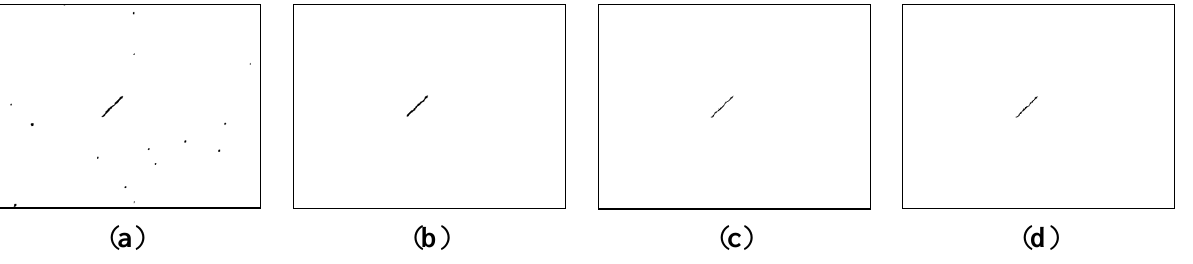
Figure 19. Detection of a MEO satellite, multiple methods. From left to right: ( a ) Motion detection using background subtraction; ( b ) Motion detection using background subtraction, followed by object classification; ( c ) Motion detection using the method described in this paper; ( d ) Object detection from stereo pairs, using the method proposed in this